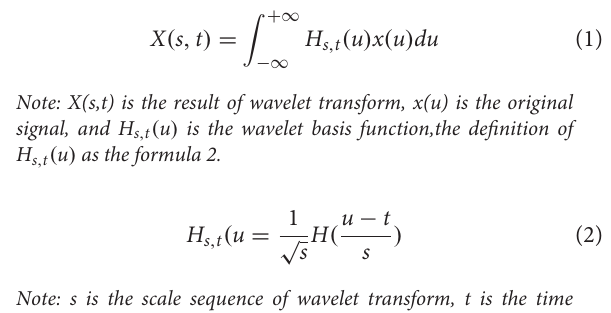
channel is marked with the pink line segment. Signals with low signal-to-noise ratios were excluded. The sampling rate was 10